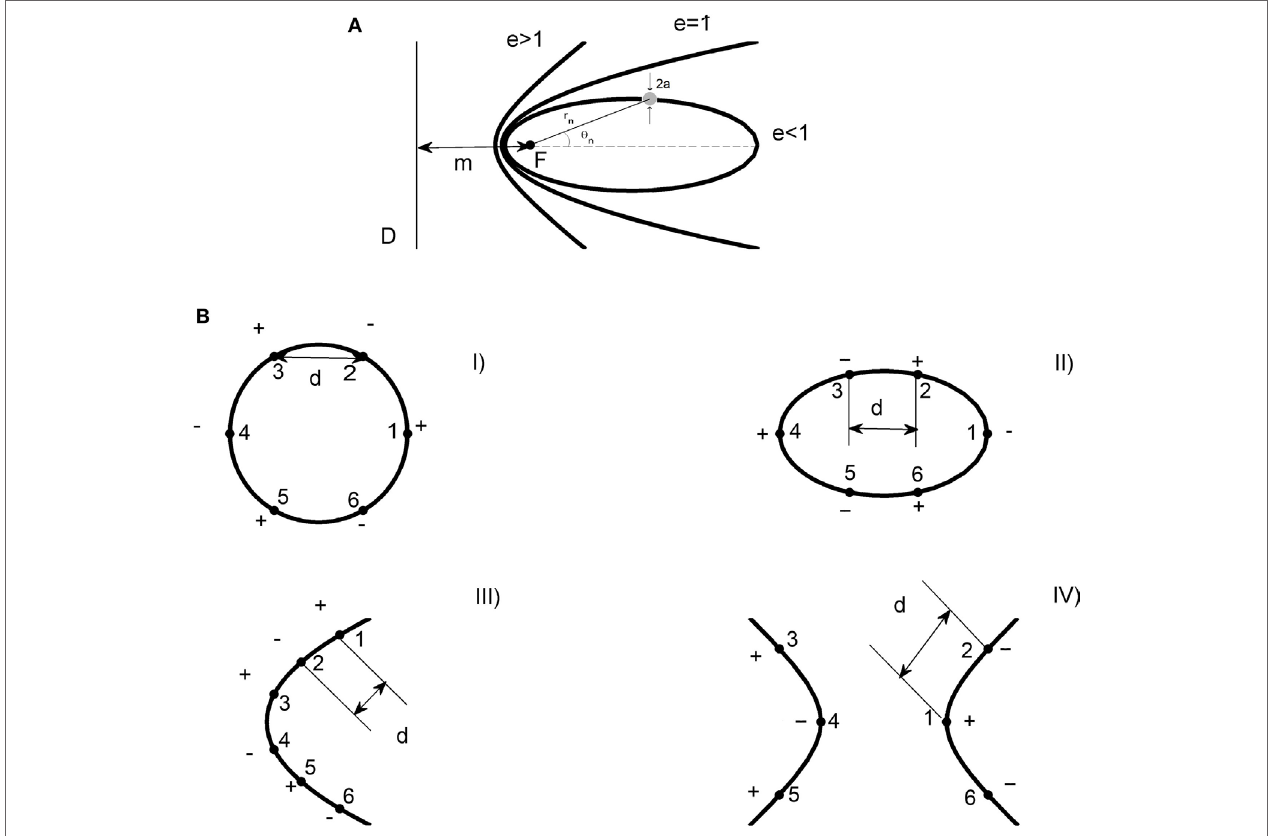
FigUre 1 | Shapes of electrode arrays. (a) Conic sections: ellipse ( e < 1), parabola ( e = 1), and hyperbole ( e > 1). F is the focus of the conic section and a the radius of the electrode. D represents the directrix line and m the distance between F and D . The parameter d symbolizes the distance between two consecutive electrodes. r n and θ n are the distance and angle of the n -th electrode, respectively. (B) Electrodes array with circular (Configuration I), elliptical (Configuration II), satellite (Configuration III), and hyperbolic (Configuration IV) shape. The numbering and polarity of each electrode is represented for the four shapes of electrode configurations